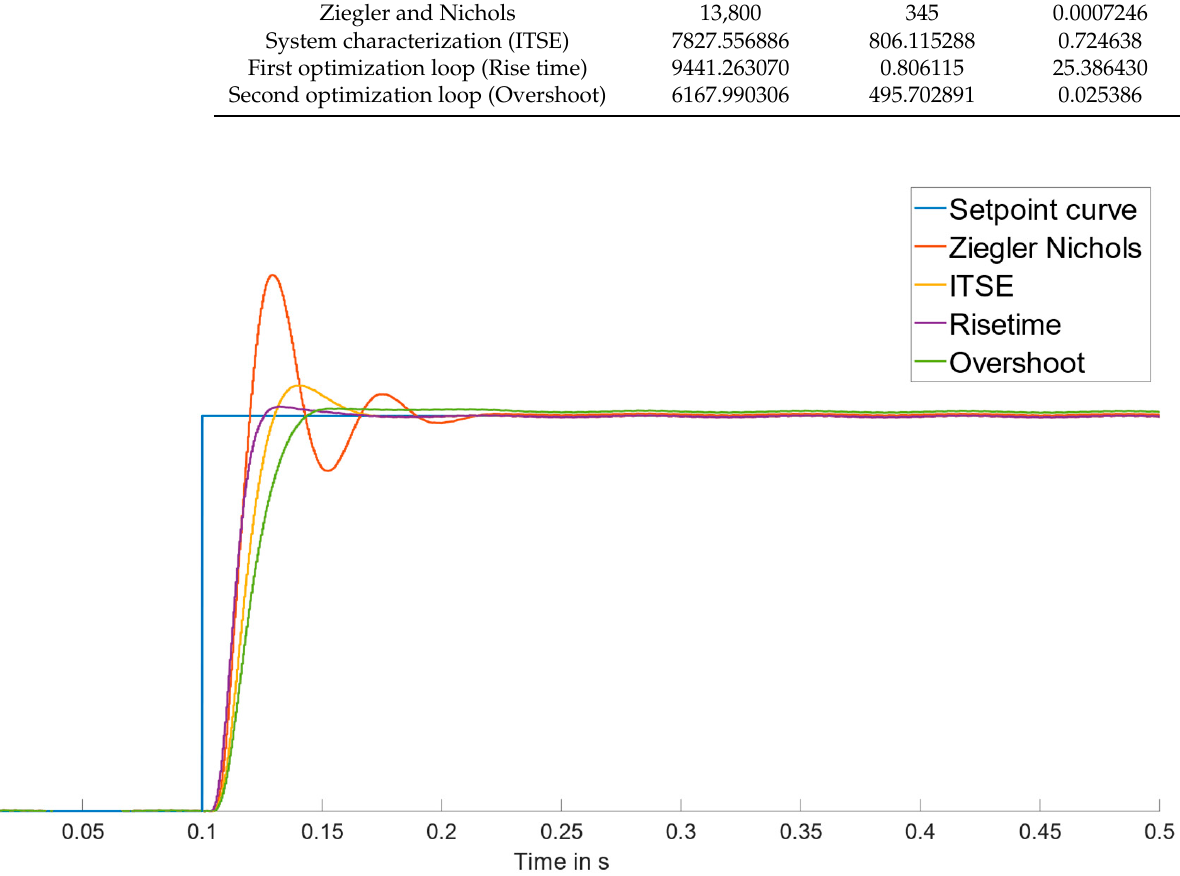
Table 4. PID parameters for Ziegler and Nichols, and the three optimization loops for the spring load of a spring stiffness of 241.381 N/mm.